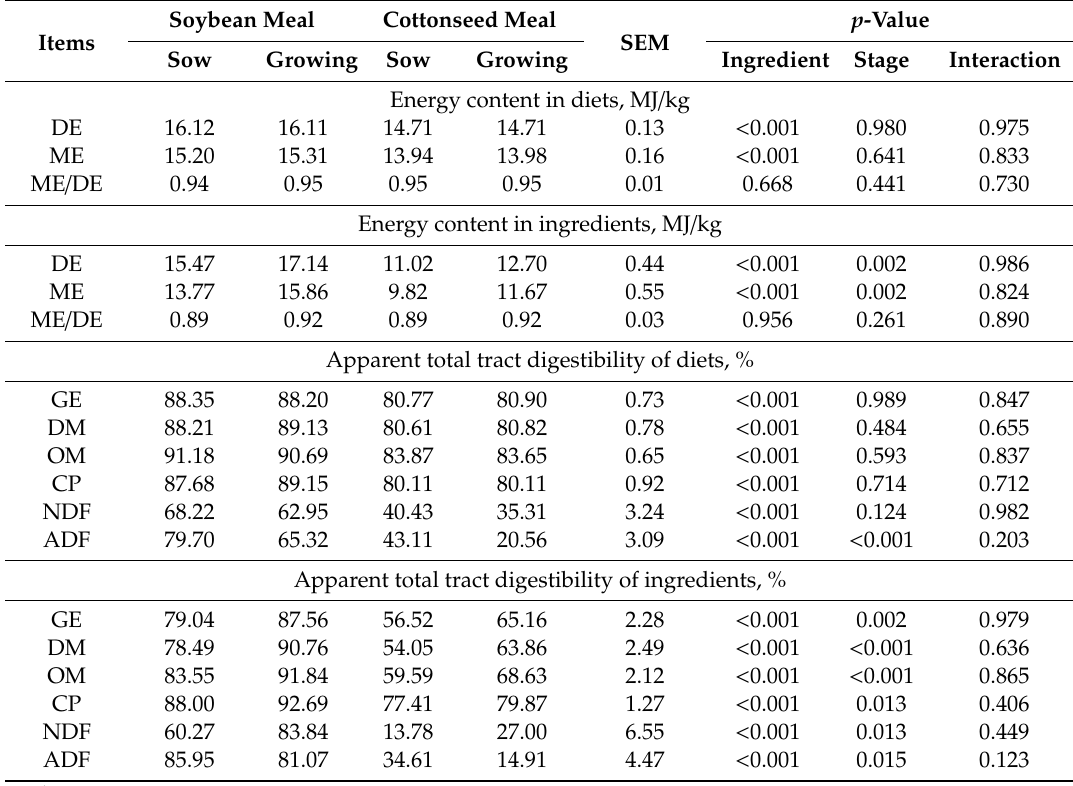
Table 4. Comparative energy and nutrient utilization in high protein low fiber (HPLF) diets and ingredients by adult sows and growing pigs 1 (dry matter